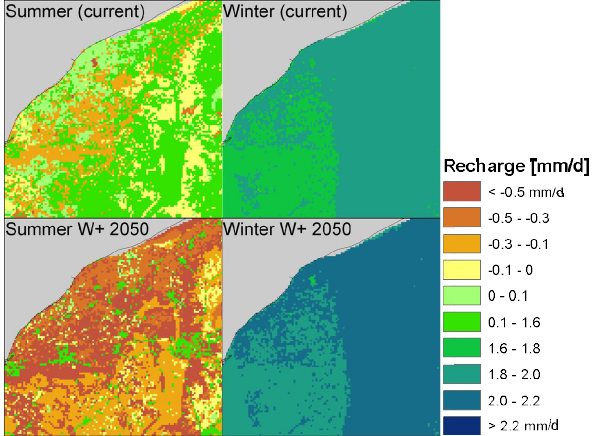
Figure 13 Groundwater recharge for the summer and the winter of the present situation (left) Fig. 13. Groundwater recharge for the summer and the winter of the and for the summer and the winter of the W+ scenario in the year 2050 (right). present situation (left panels) and for the summer and the winter of the W+ scenario in the year 2050 (right panels).